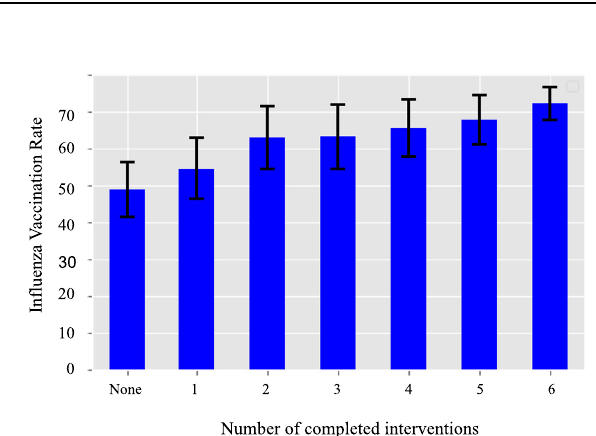
Fig. 3 Vaccination rate per completed interventions for people with diabetes in the intervention group. Depicts the in fl uenza vaccination rate for the PWD-I People with diabetes-intervention group, based upon the number of the intervention messages that were completed during the intervention period with standard different between the two groups, indicating that randomization was successful. The participants were predominantly female, White, and in the middle age range and had high levels of income and education. Hypertension, depression, and high cholesterol were the most commonly reported comorbidities, with a small proportion reporting coronary artery disease. Participants included individuals from 48 of the United States, as well as the District of Columbia, United States Armed Forces, and Guam. A total of 101 individuals reported discrepant answers at the 3-month and 6-month questionnaires with regard to vaccination status. The effect size remained unchanged and statistically signi fi cant after re-running the primary outcome without these individuals.